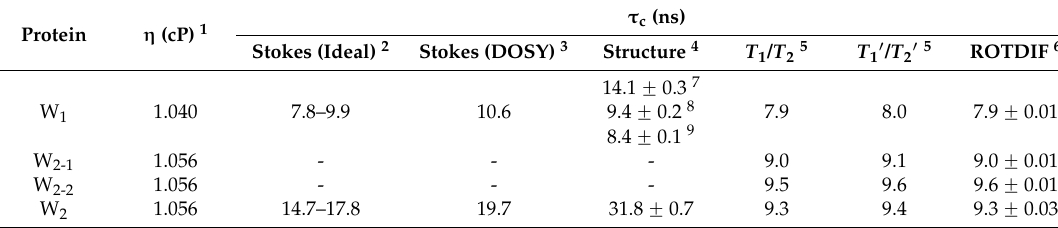
using Stokes’ law (Equation (5)) based upon hydrodynamic radii determined by DOSY [19]; 4 Average ± average deviation of HYDROPRO [55] predicted τ c over 20-member ensembles of structures of W 1 or W 2 [19], or over globular core of W 1 ; 5 Determined based upon indicated relaxation time constant ratio using Equation (7); 6 Average ± average deviation over all 20 structural ensemble members determined through axially-symmetric diffusion tensor ROTDIF in identical manner to Table 1; (residues 12–128).